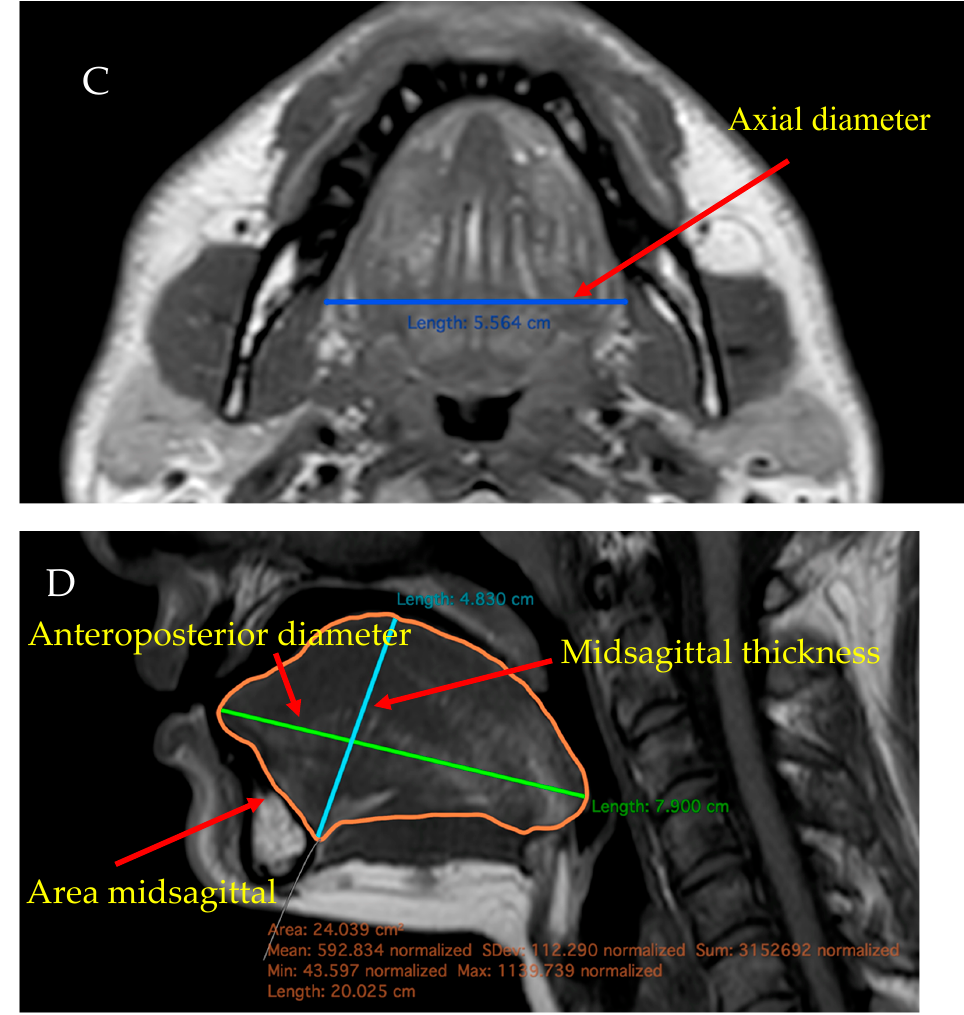
Figure 2. ( A , D ) sagittal, ( B ) coronal, ( C ) axial T1 TSE MRI scans showing the anteroposterior, axial, coronal, sagittal, and midsagittal diameters, and also the calculation of Fat% (taken from our data).